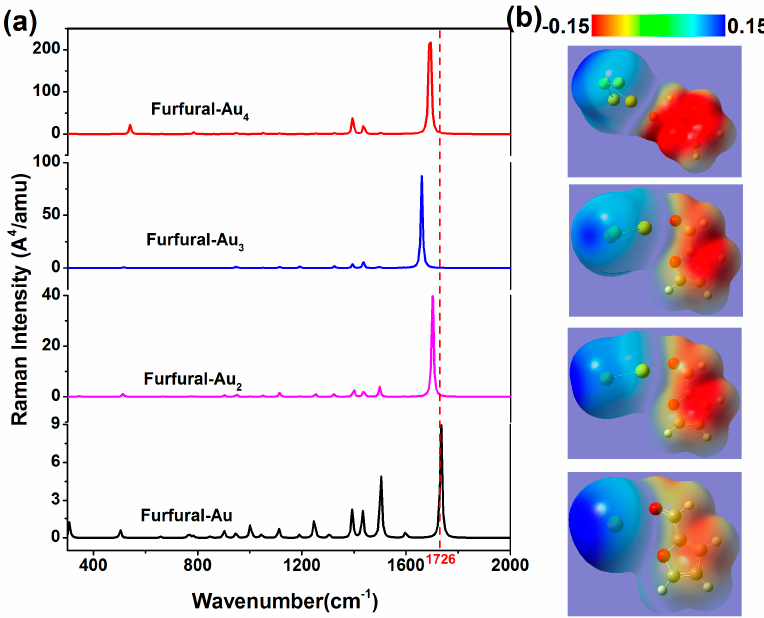
Figure 4. ( a ) The theoretical Raman spectra of furfural-Au X complexes with different atomic numbers (red dotted lines indicate characteristic peaks 1726 cm − 1 ); ( b ) The static potential distribution of furfural-Au x ( x = 1, 2, 3, 4). Nanomaterials 2017 , 7 , 210 Table 3. The charge transfer and bond length (C=O) of furfural-M x (M = Au, Cu). Au Cu Atom Number